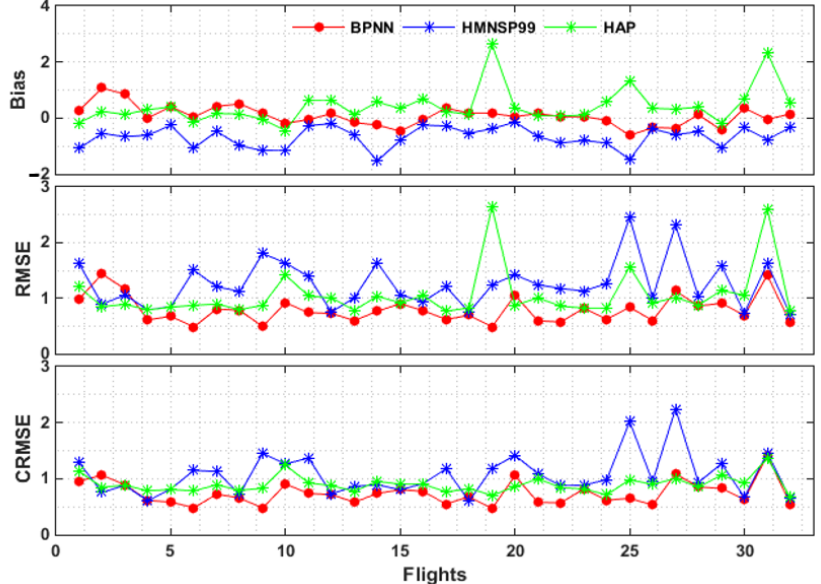
Figure 5. Statistical analysis of lg C 2 n calculated by the BPNN approach, HMNSP99 model and HAP model for all samples of individual meteorological balloons.